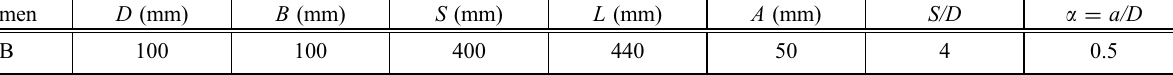
Table 4 Geometrical parameter values of notched beams used in TPB tests.